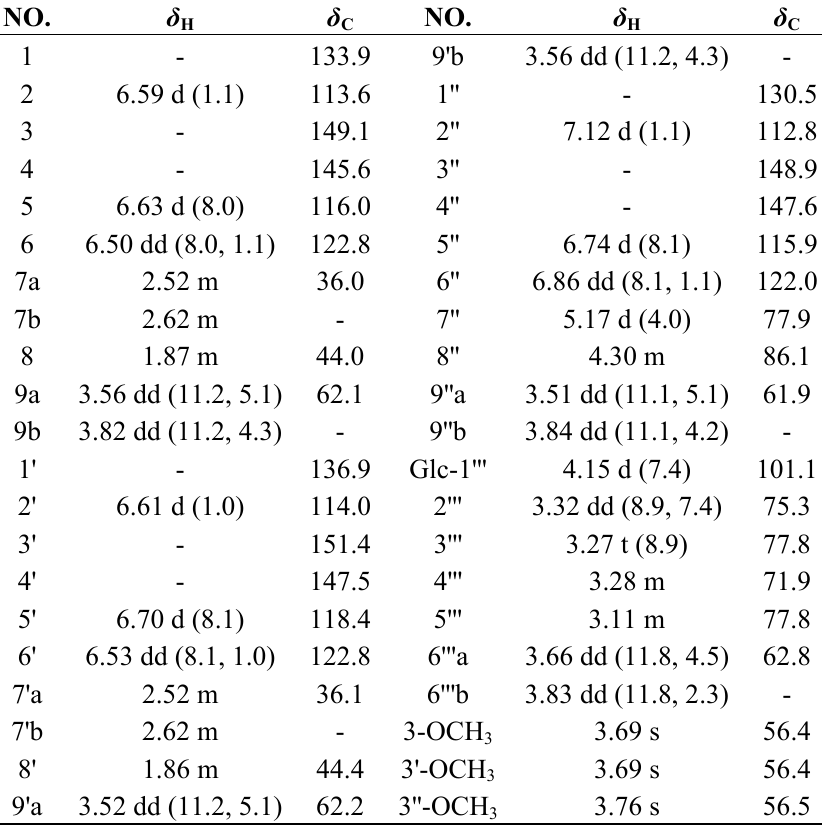
Table 1. 1 H-NMR (400 MHz) and 13 C-NMR (100 MHz) data of compound 1 (in CD in ppm, J in Hz).